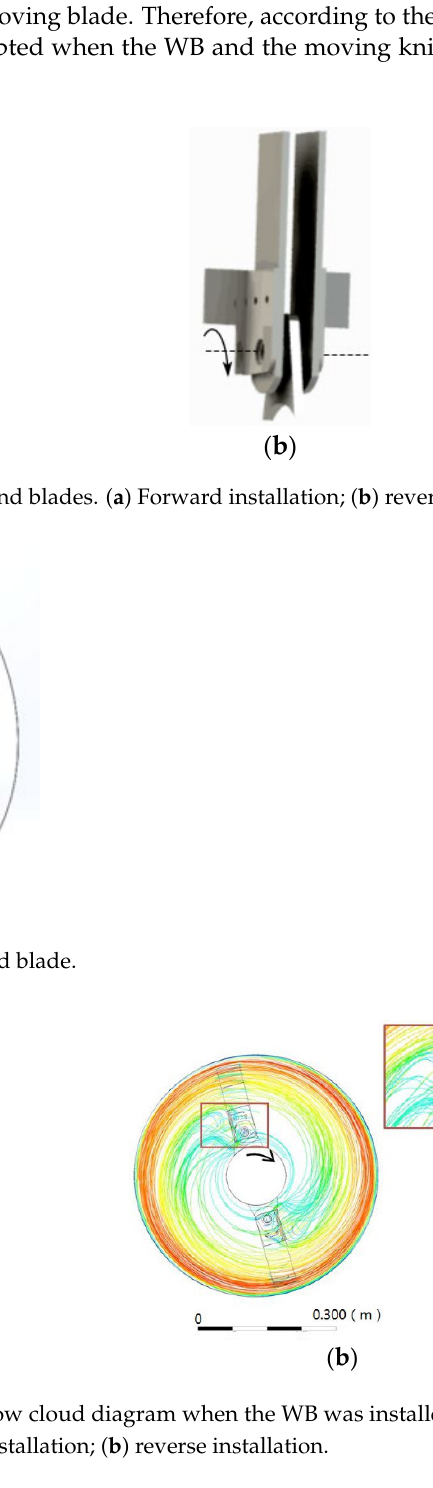
Figure 14. Rotation model of wind blade.